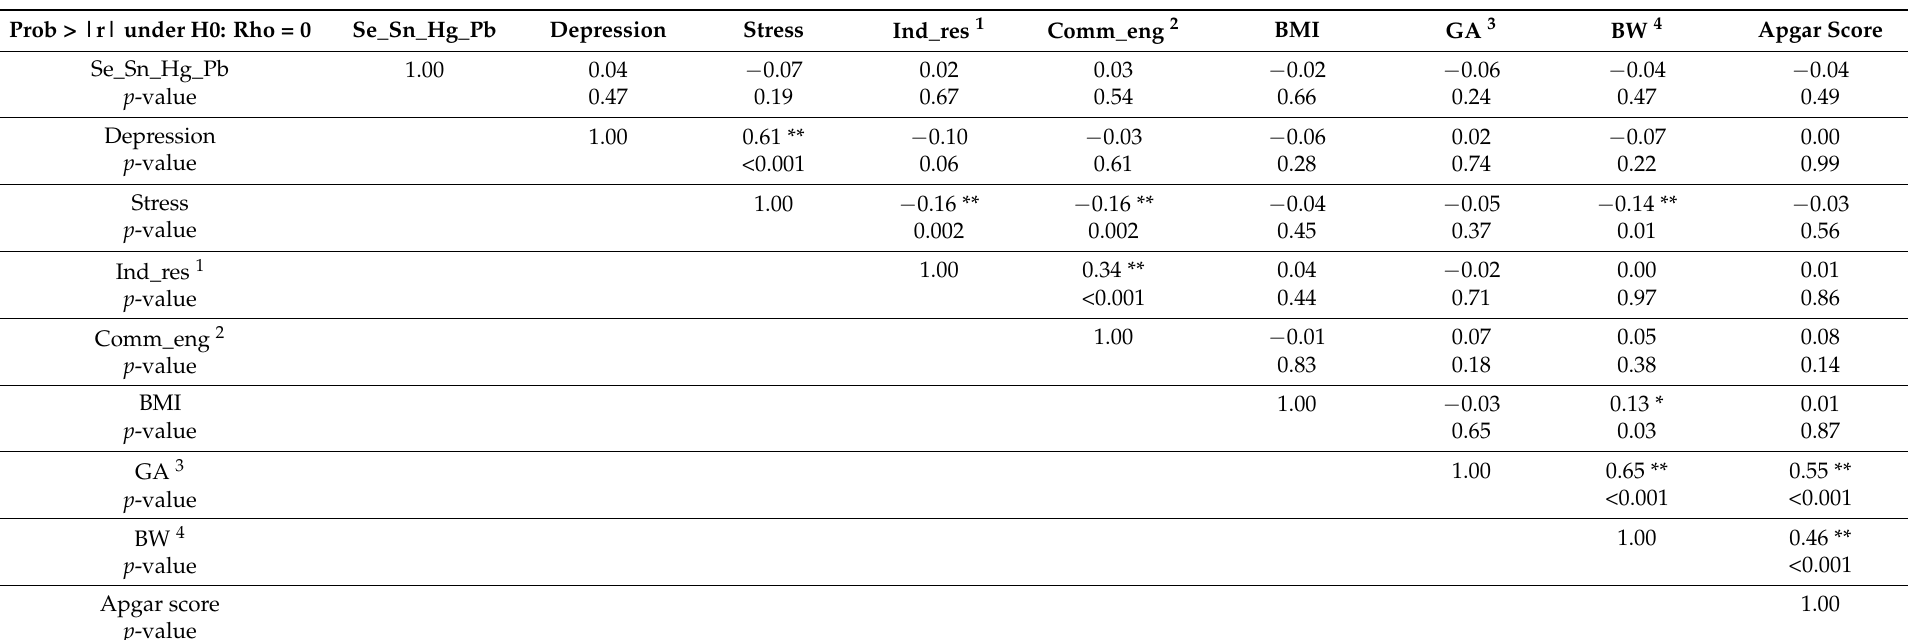
Table 3. Pearson correlation coefficients of latent chemical construct, depression, perceived stress, social support, BMI and birth